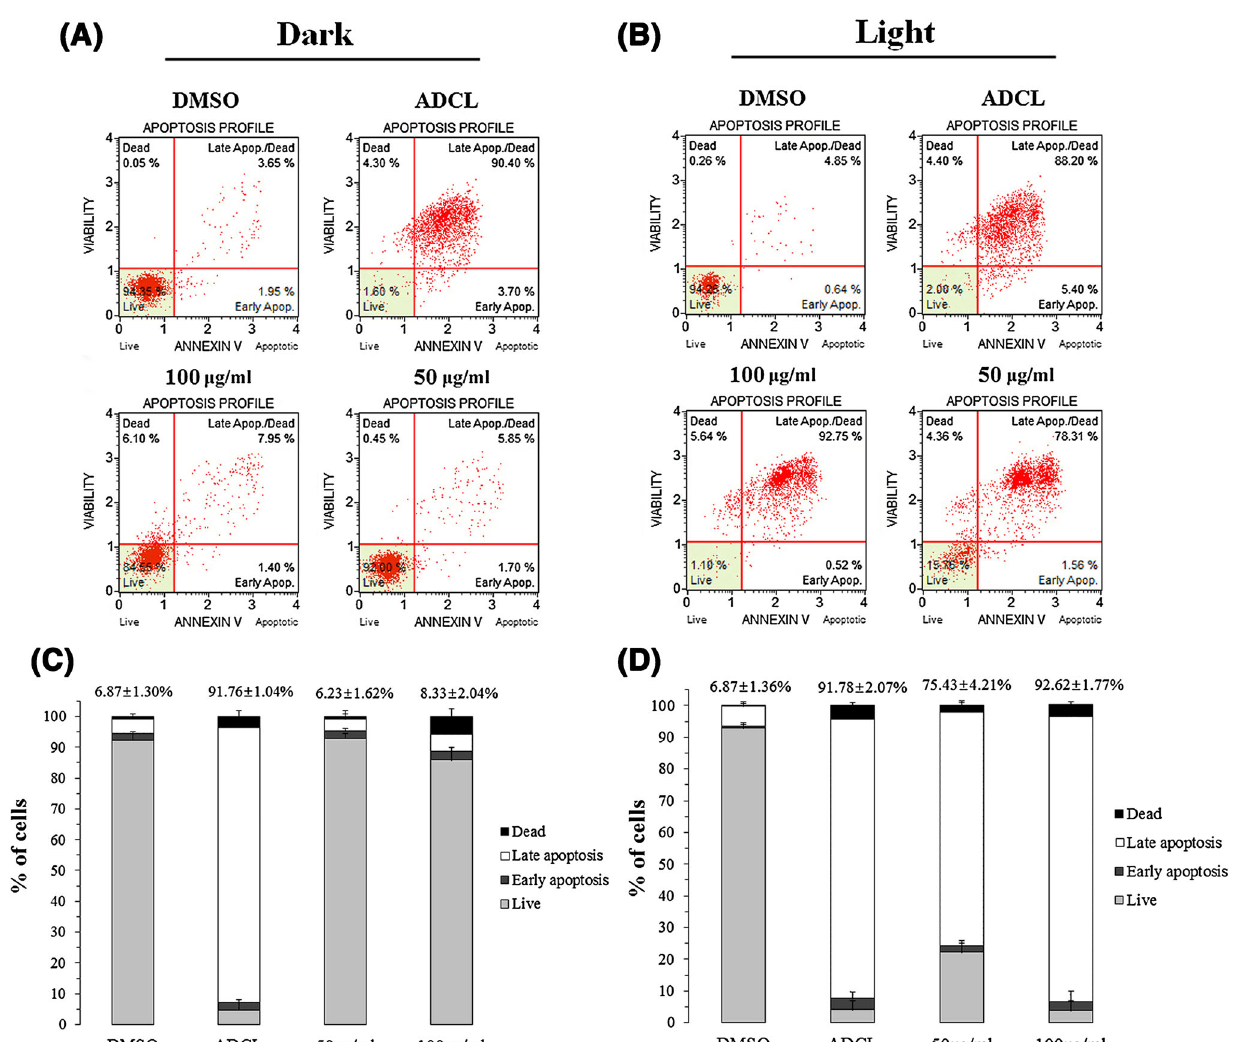
Fig. 5 U937 cells viability by BNCE treatment and light irradiation. Cells were treated with BNCE (50 and 100 l g/ml) for 4 h. Irradiated with light for 10 min or kept in the dark, followed by incubation for 6 h. Cells were stained using a Muse TM Annexin V and Dead cell kit for 20 min and analyzed using a Muse TM Cell Analyzer. Results show a dose-dependent increase in the number of apoptotic U937 cells compared to dark conditions. ( A ), ( B ) Scatter plots showing